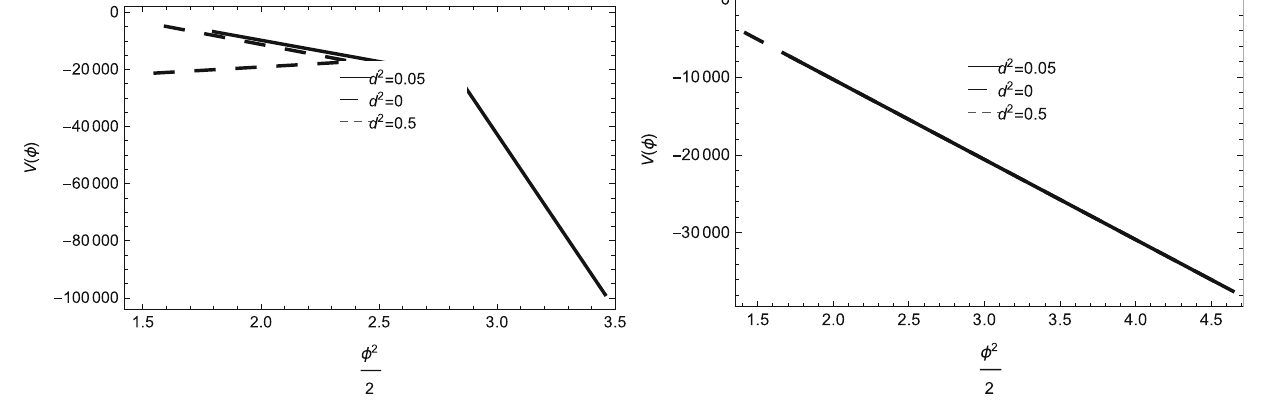
Fig. 39 Plot of φ verses V for u = 1 and u = 2 . 002 for tachyon scalar field